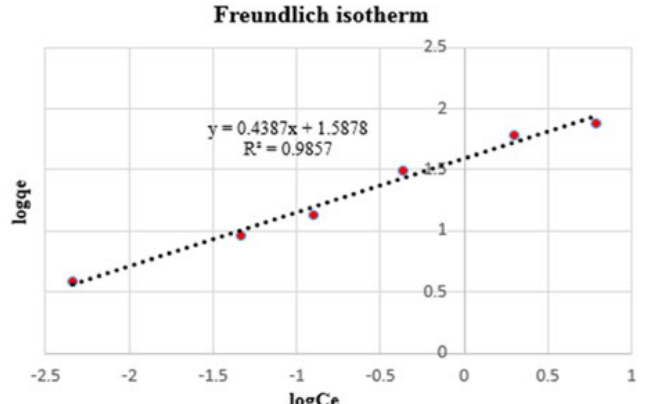
Fig. 10. Langmuir isotherm model for adsorption of cadmium by palladium oxide nanoparticles